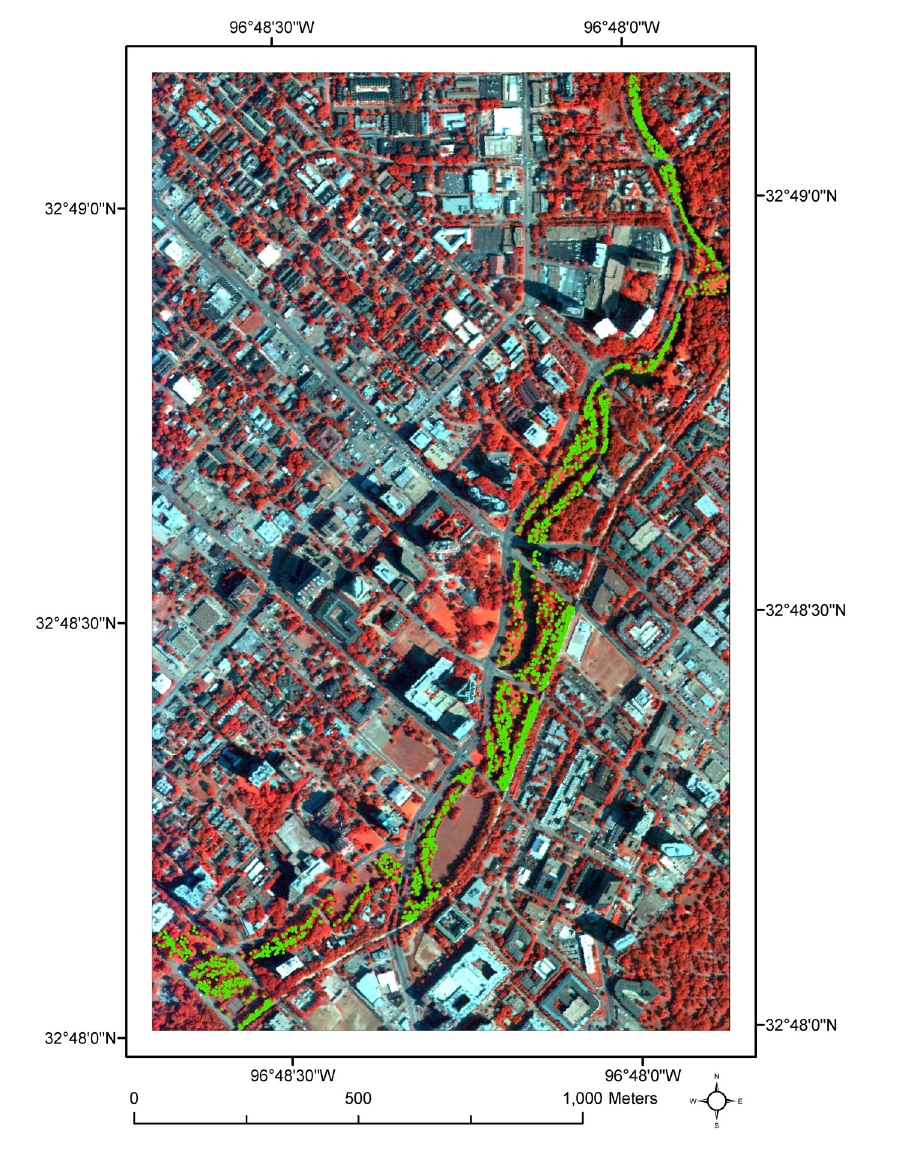
Figure 2. Study site shown in a color composite from the collected hyperspectral data. Measured tree locations are shown in green